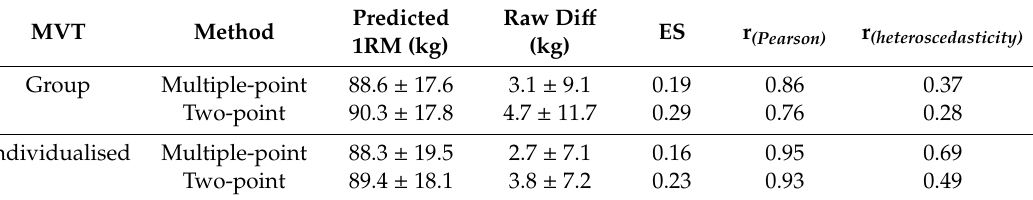
Figure 2. Comparison of the absolute differences (mean ± SD) between the actual 1 repetition maximum (1RM) and the 1RM estimated using the different prediction methods in the squat exercise. Note: the black rectangle denotes the median value, while the circles represent individual data points. Table 2. Differences, associations and heteroscedasticity of the errors between the actual and predicted one-repetition maximums (1RM) during the squat exercise.